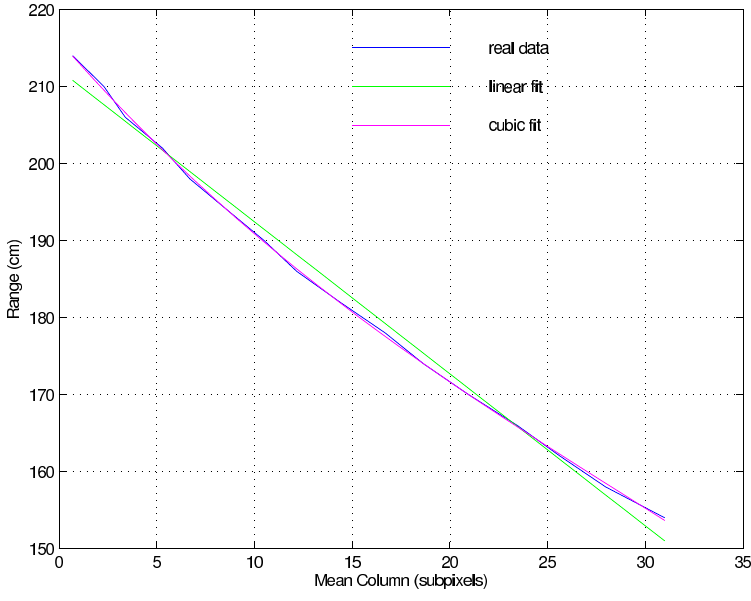
Figure 5. Linear and cubic adjustments for the relation